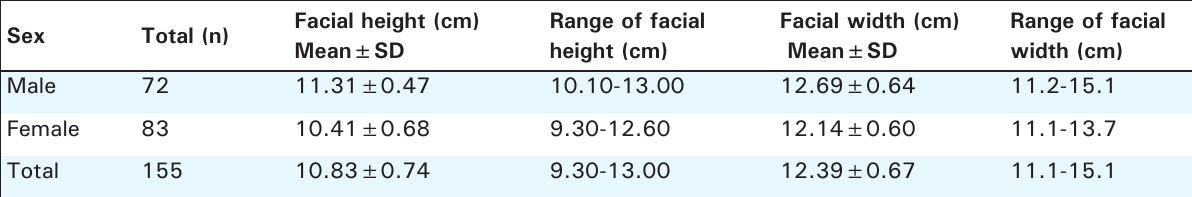
Table 1. Mean and SD of facial height and facial width among medical students.